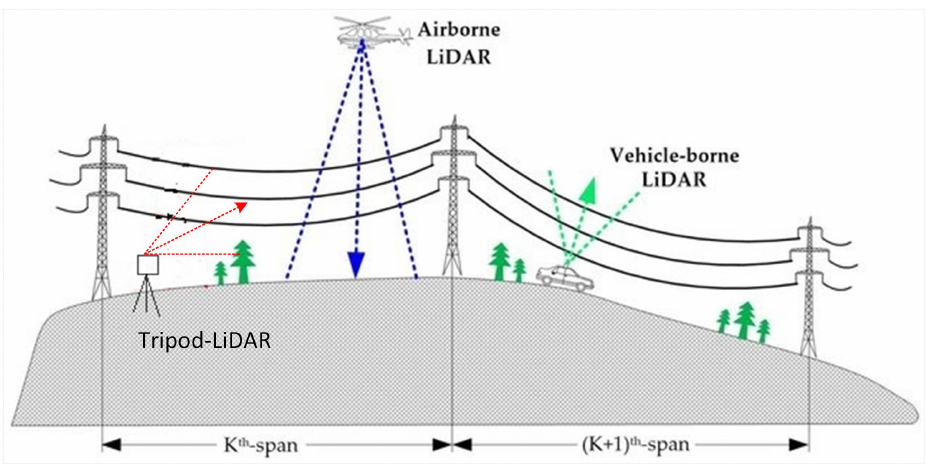
Figure 2. Power lines Mapping Systems [45].